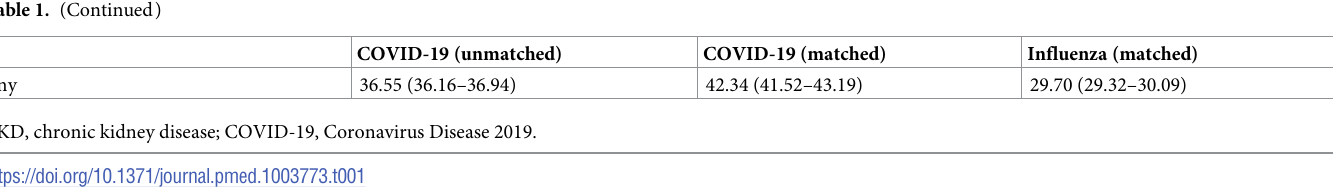
control) was not statistically significantly different from 1 (HR 1.05, 95% CI 0.91 to 1.23, p = 0.51 for the 1- to 180-day period; and HR 1.07, 95% CI 0.87 to 1.32, p = 0.52 for the “long” phase). The absolute risk increase of any long-COVID feature after COVID-19 compared to influenza was 16.60% (95% CI: 15.84% to 17.33%) for the whole follow-up window and